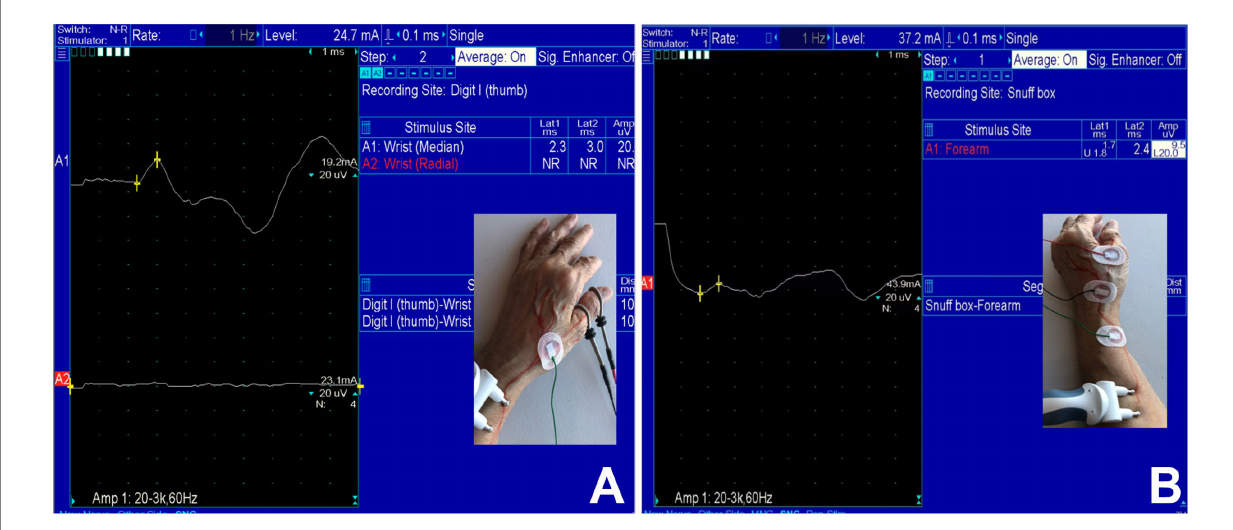
FIGURE 1 Case 33: (A) Absence of sensory nerve action potentials (SNAPs) of the superficial radial nerve (lower trace) and intact SNAP of the median nerve over the thumb (upper trace). (B) Recordable SNAP of the SRN with prolonged latency and decreased amplitude over the anatomical